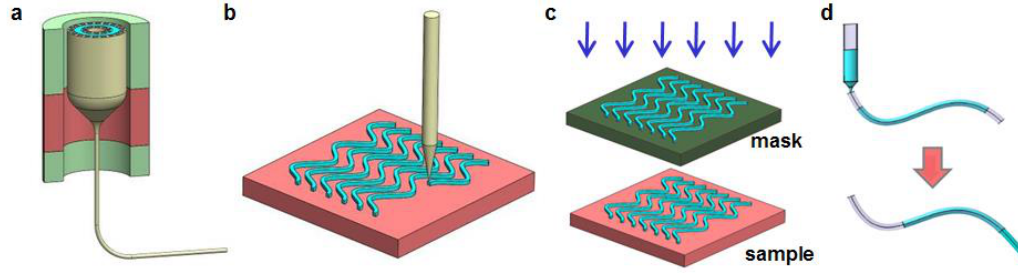
Figure 1. Schematic overview of representative approaches for fiber/waveguide fabrication. ( a ) Thermal drawing. ( b ) Printing. ( c ) Lithography. ( d ) Molding.